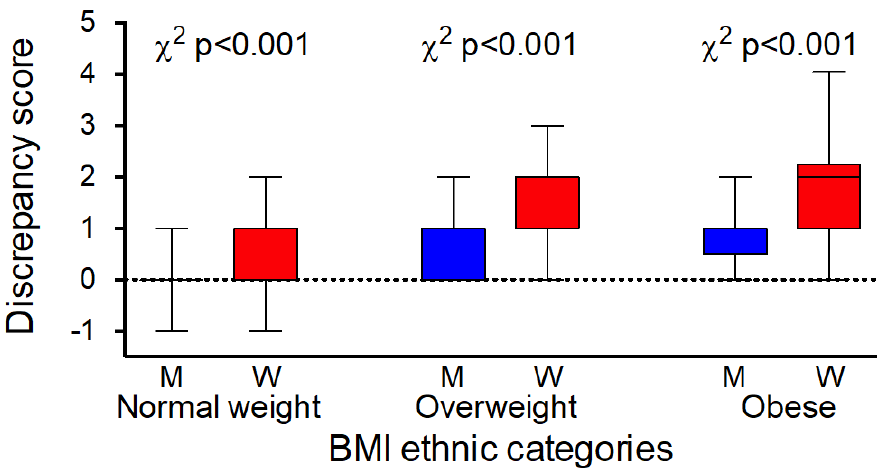
Figure 2. Distribution (length of the box is the difference between the 75th and 25th percentiles, ends of the box are 9-95th percentile) of discrepancy score in the Chinese cohort by gender (M, men and W, women) and BMI ethnically specific categories.